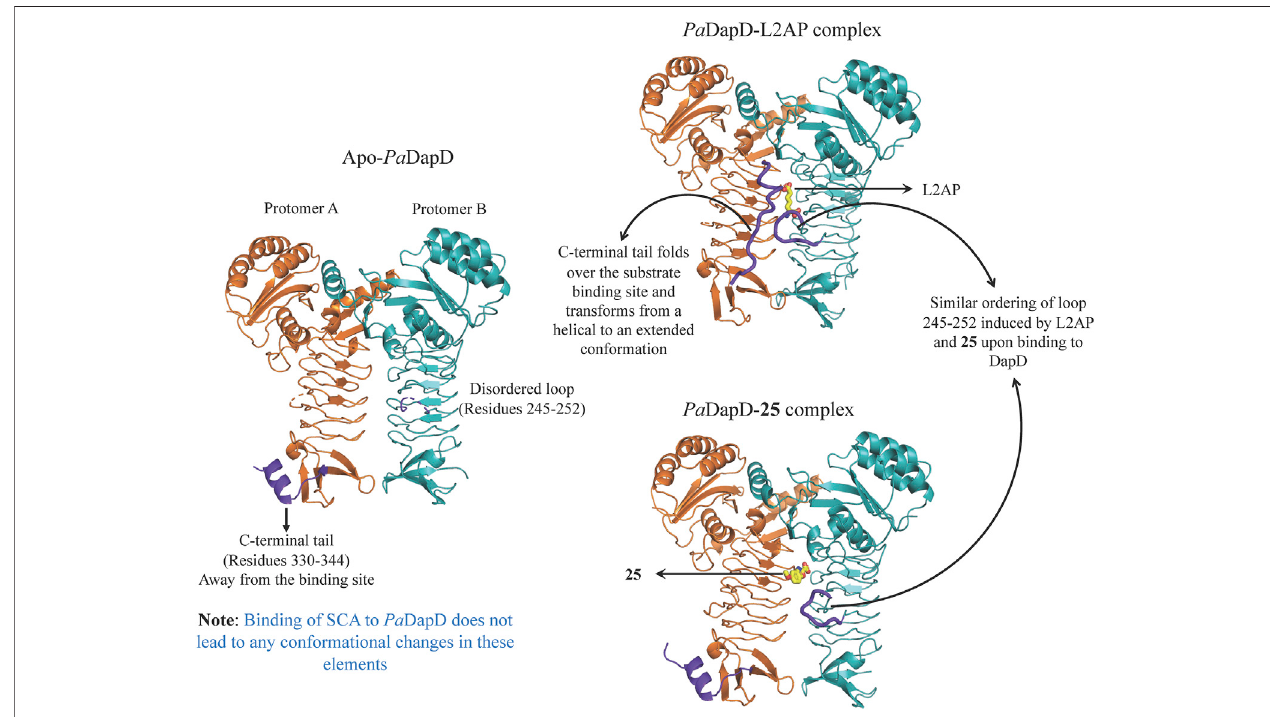
FIGURE 9 | Conformational changes observed in Pa DapD upon binding of ligands. Signi fi cant changes are observed in the C-terminal tail 330 – 344 and loop 245 – 252 (both in purple) upon binding of the substrate analog L2AP alone to Pa DapD. Interestingly, binding of 25 leads to ordering of loop 245 – 252 in a similar way to that observed on binding of substrate analog L2AP to Pa